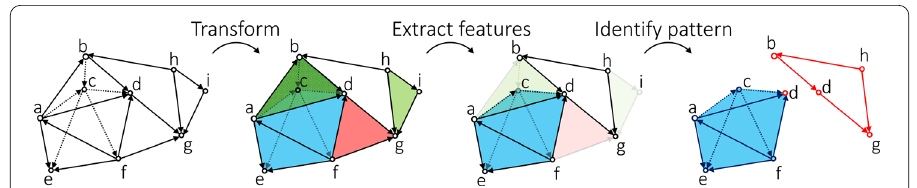
Figure 2 Pipeline for persistent homology. Given a directed network, a simplicial complex is constructed. Topological features in the simplicial complex are then extracted using tools from algebraic topology and are used to identify corresponding flow patterns in the directed network